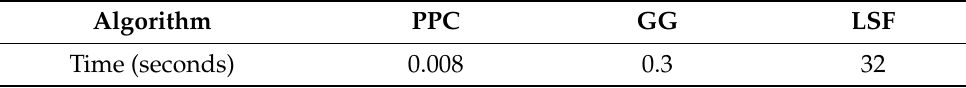
Table A1. Averaged single-frame computation time consumed for the three algorithms to extract pho- ton positions in the same contrast extraction ROI as in Figure 1a using a single core of Intel(R) Xeon(R) CPU E5-2620 v4 processor. The computation time average was performed over 1000 consecutive frames with the incident X-ray beam in the tight focus condition (in focus, 5 µ m). The GG and LSF algorithms can be sped up by reprogramming in C.